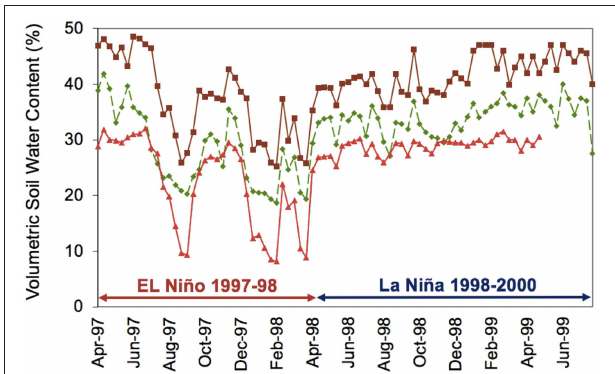
FIGURE 11 | Temporal dynamics of 10-day mean values of volumetric soil water content at 40cm depth, recorded at three nearby parcels in the Central Andes of Colombia under different vegetation types: shaded coffee (brown), secondary forest (green), and sunlit coffee (red). The studied period